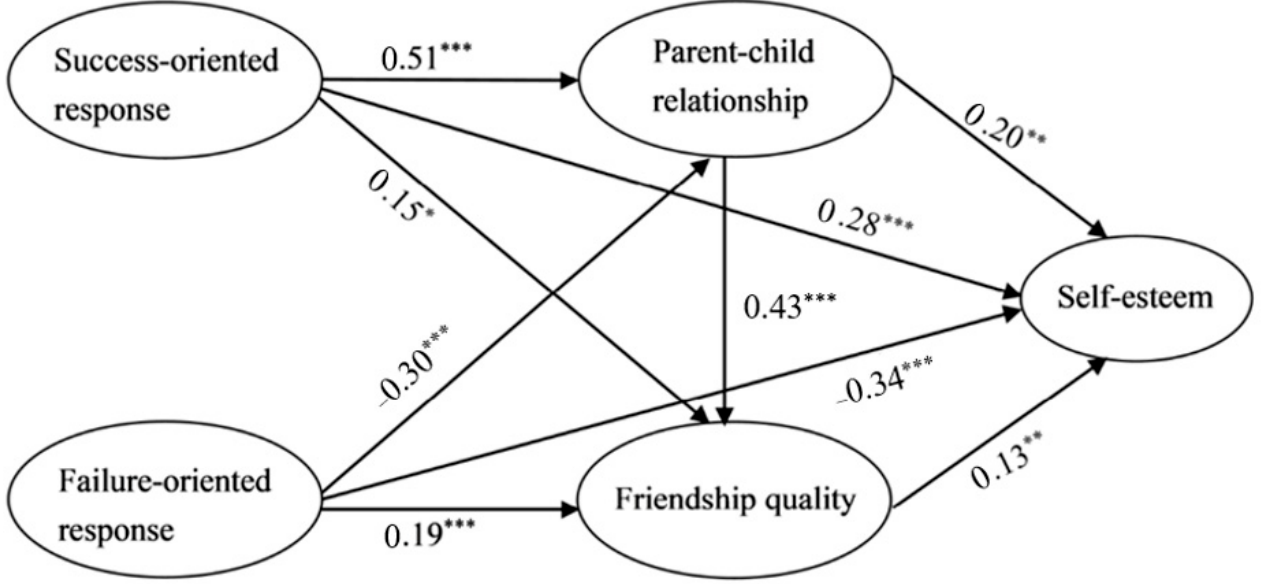
Figure 1. Serial mediating role of parent–child relationship and friendship quality ( N = 859). * p < 0.05, ** p < 0.01, *** p < 0.001.